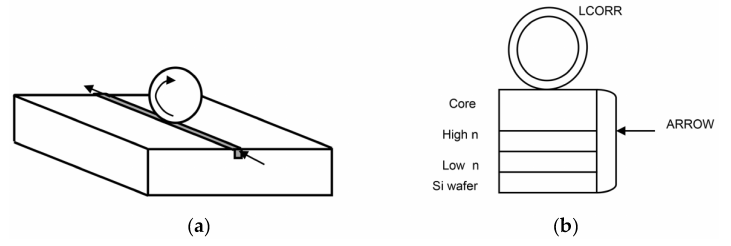
Figure 5. Sketch of hybrid WGM sensors: ( a ) microsphere coupled with a waveguide; ( b ) LCORR-anti-resonant reflecting optical waveguides (ARROW) system and cross-section viewed from the LCORR (liquid core optical ring resonator) on top of an